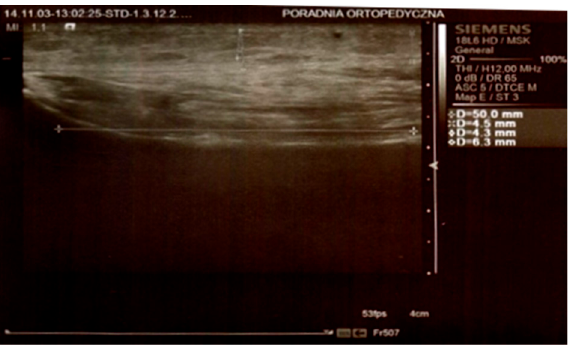
Figure 2. Ultrasound scan. Measurements 25 mm below the neck of the fibula and 50 mm below the neck of the fibula.